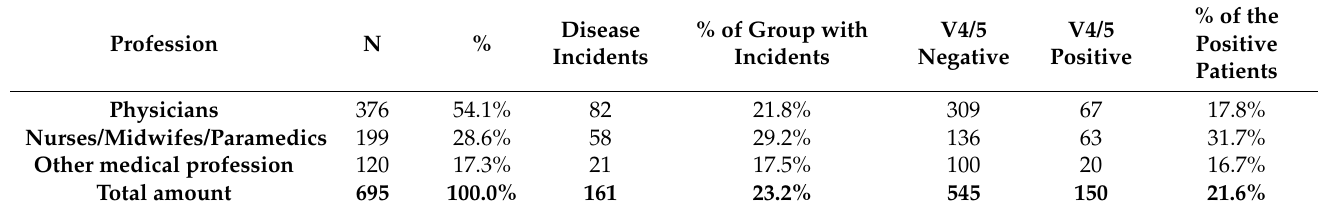
Table 9. Percentage of COVID-19 disease incidents by the medical profession.